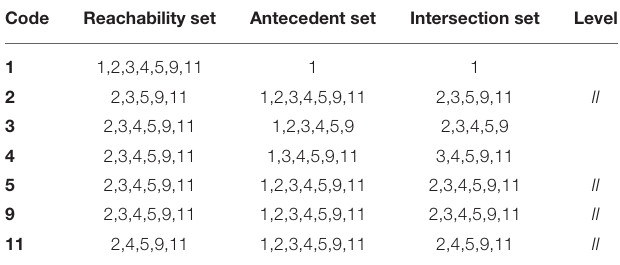
TABLE 7 | Iteration II.